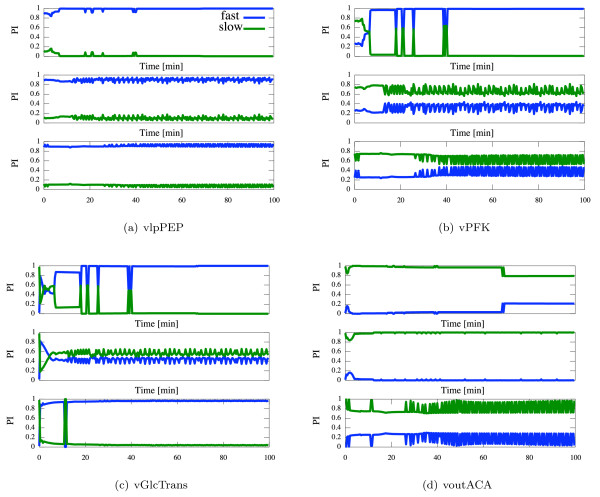
The time evolution of the normed sum of Participation Indexes (PI) for vlpPEP (a), vPFK (b), vGlcTrans (c) and voutACA (d). Upper, middle and lower panel relate to [Glcx]0 = 9 mM, 14 mM and 24 mM, respectively. Blue and green curves show the contribution to the entire fast and slow subspace, respectively.